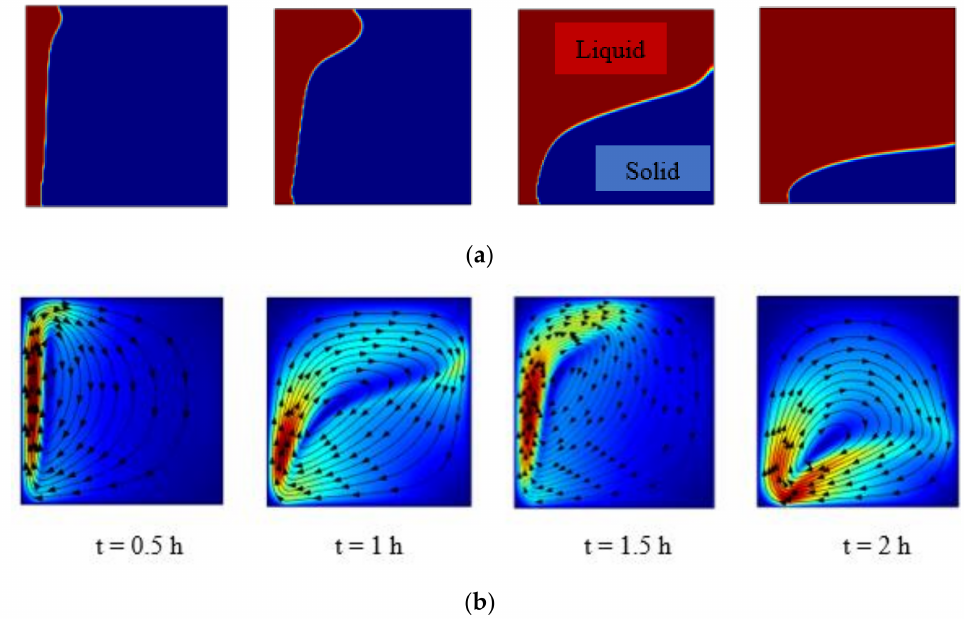
Figure 15. Temporal distribution of liquid fraction and streamlines during charging of NaNO 3 domain for q” = 7500 W/m 2 . ( a ) Liquid fraction and ( b ) streamlines in the velocity